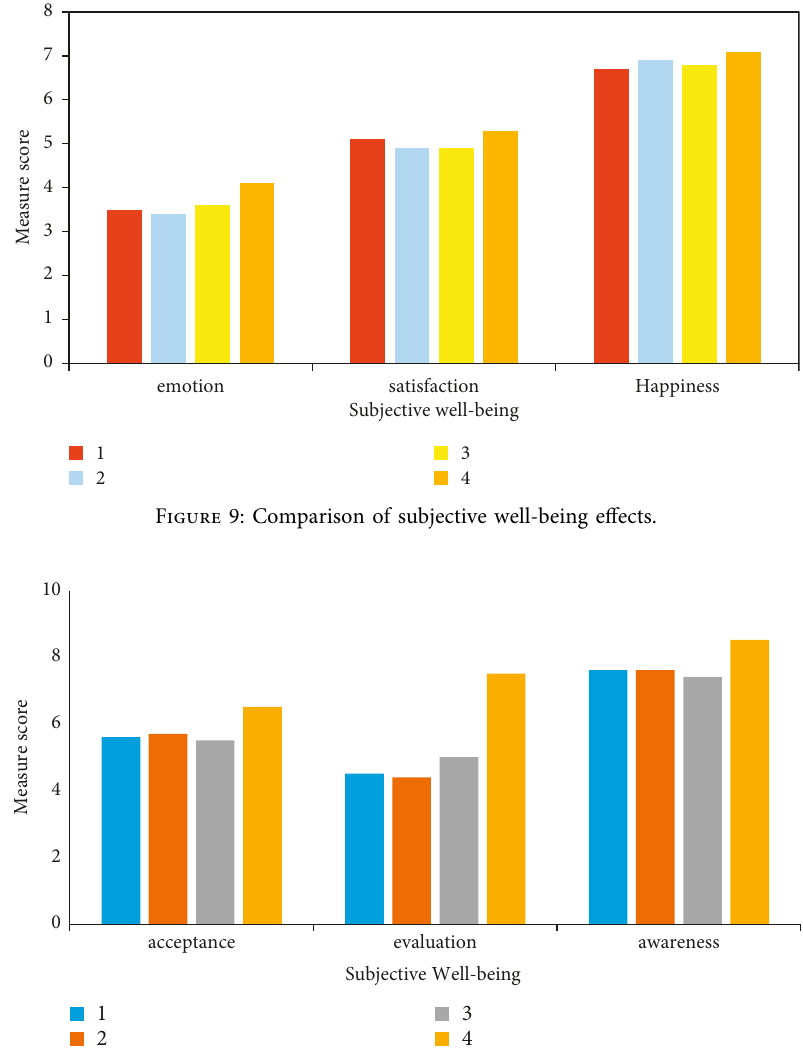
Figure 10: Comparison of self-acceptance impact results.